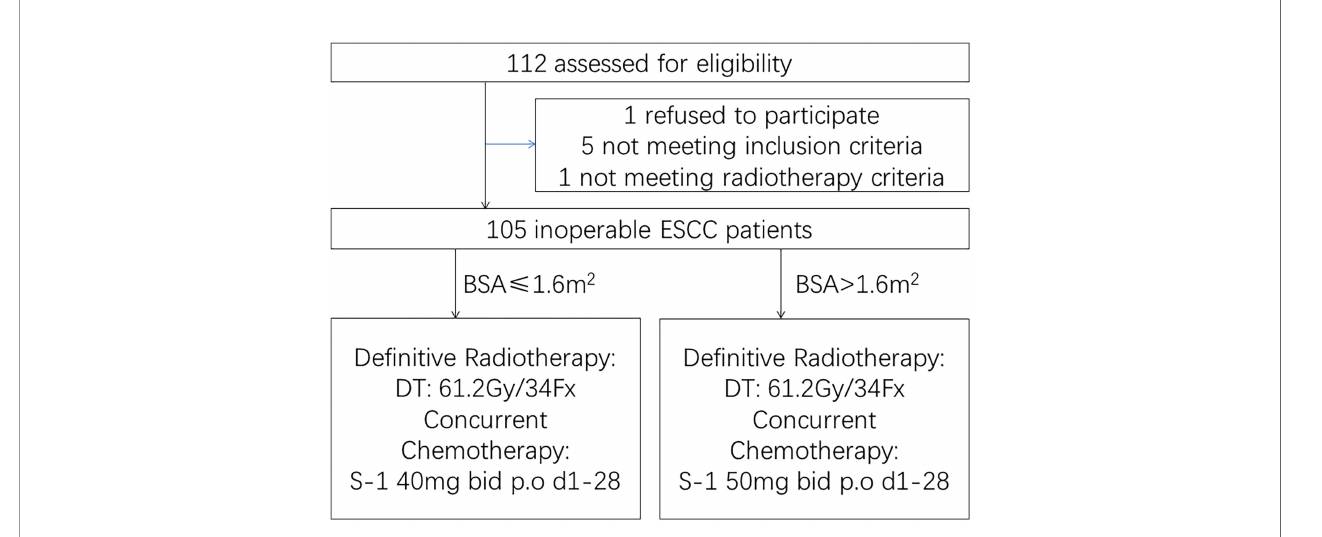
FIGURE 1 | Trial pro fi le. One hundred fi ve inoperable esophageal squamous cell carcinoma patients who were aged >75 years or rejected or were intolerant to intravenous chemotherapy due to serious medical comorbidities were